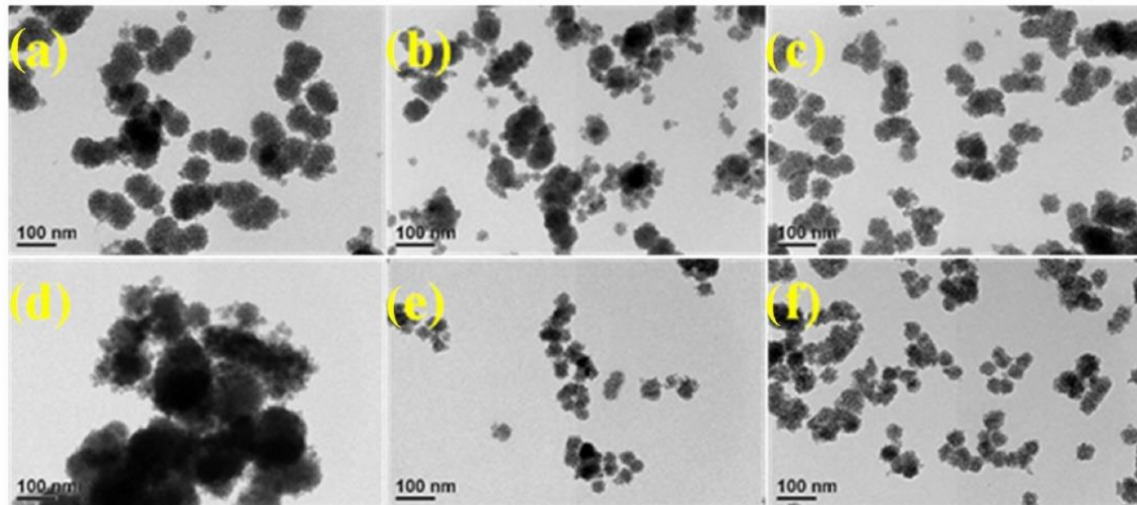
Figure 2. TEM images of ZnS/COF composite photocatalyst with different COF ratios: ( a ) ZnS, ( b ) ZnS/0.5COF, ( c ) ZnS/1COF, ( d ) ZnS/2COF, ( e ) ZnS/4COF, ( f )